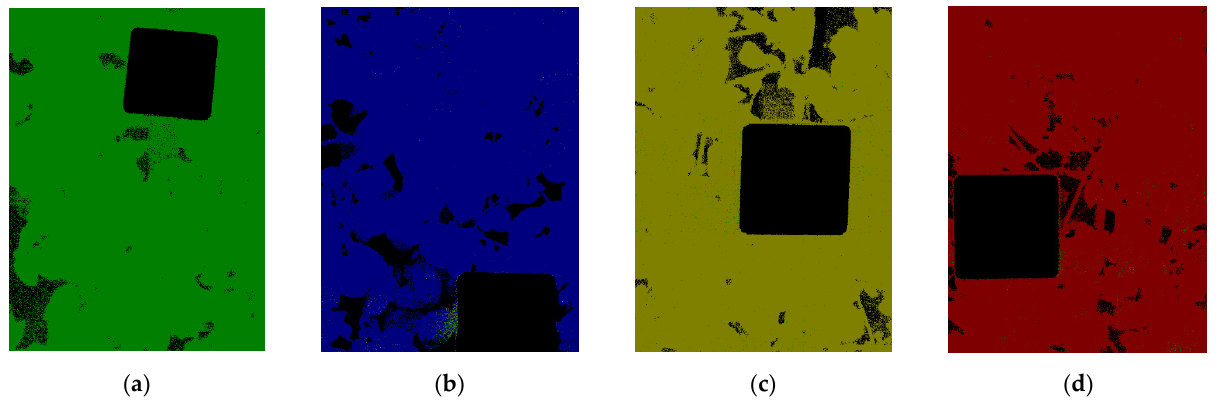
Figure 11. XGBoost classification of ( a ) control plant, ( b ) plant with light stress, ( c ) plant with moderate stress, ( d ) plant with severe stress.